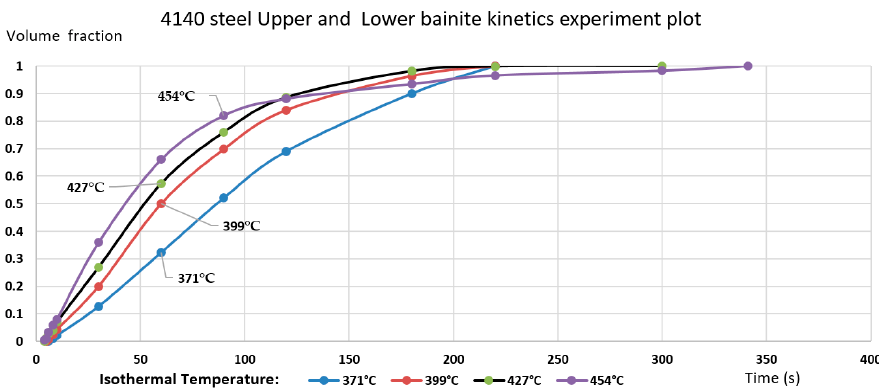
Figure 2. Transformation kinetics curves of 4140 steel from 454 °C to 371 °C.